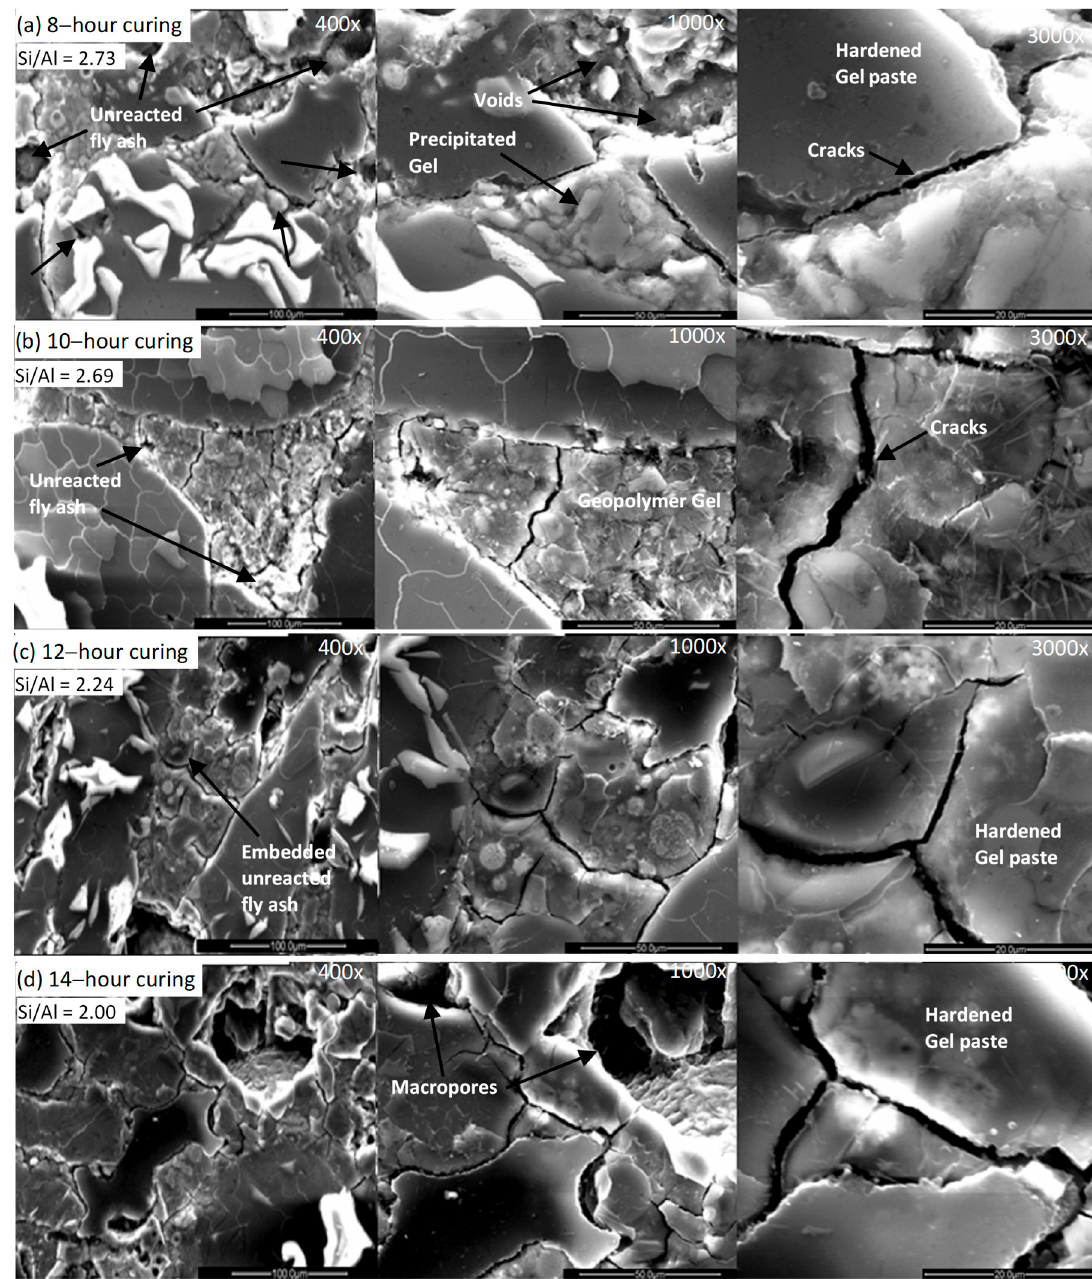
Figure 7. The microstructural development of geopolymer mortar (50 mm cube) at 8, 10, 12 and 14 h of heat curing.